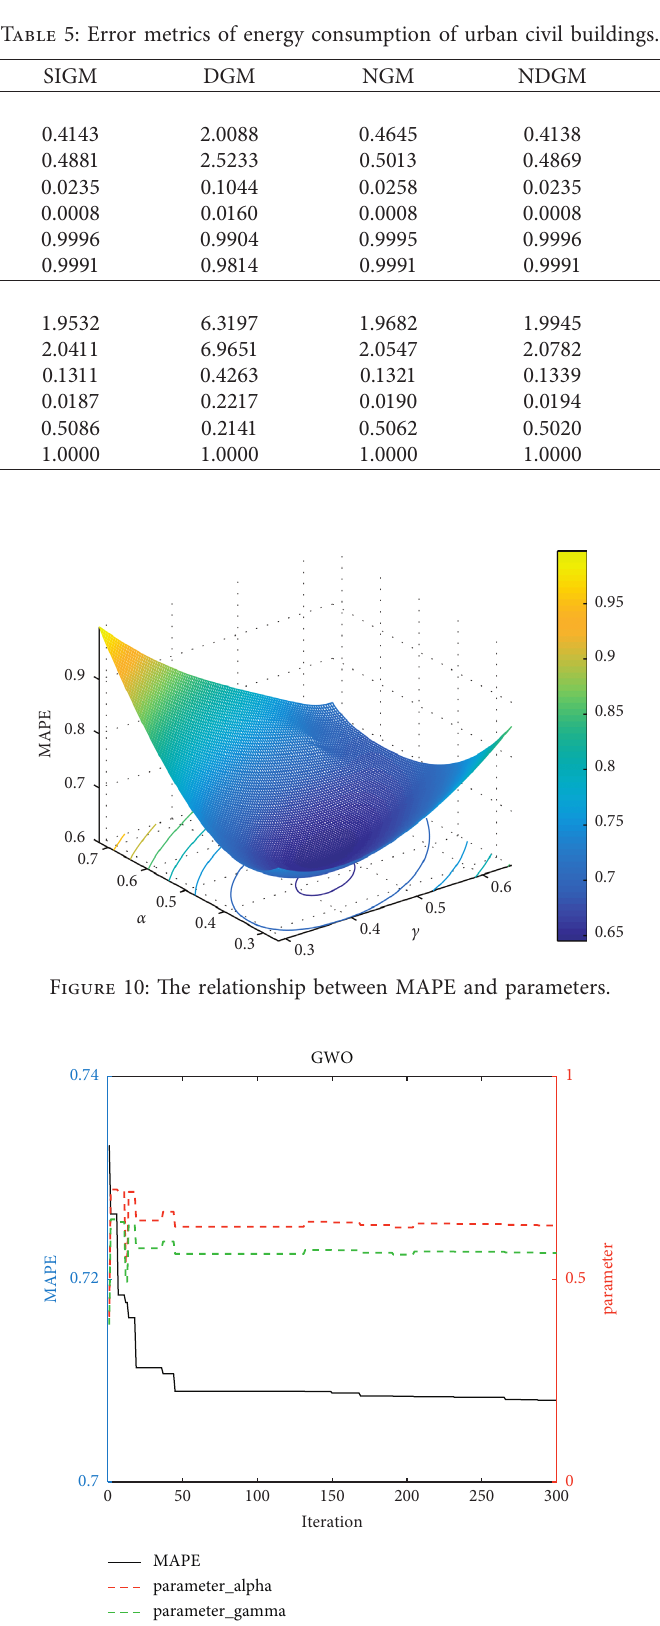
Figure 11: Iterations, MAPE, and parameters of the GWO